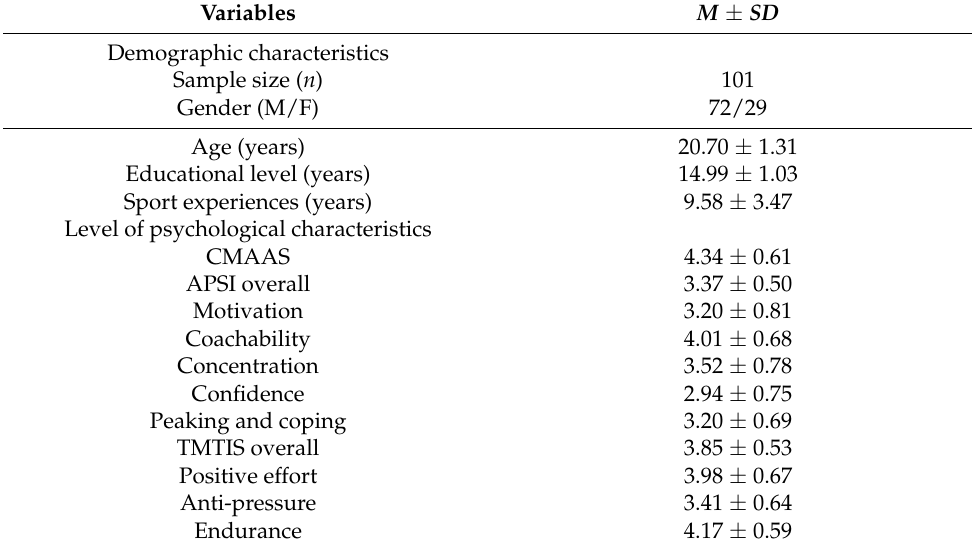
Table 1. Demographic characteristics and level of psychological characteristics.